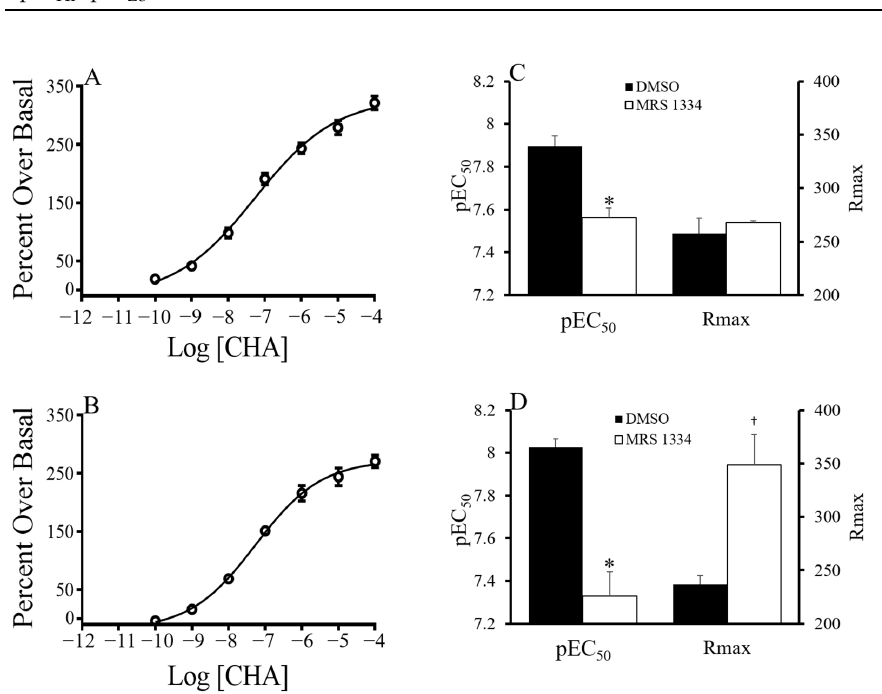
Figure 3. CHA-induced 35 S-GTP γ S binding in summer and torpid AGS brain tissue. Three brain tissues were analyzed: forebrain (n = 6, 5; summer, torpid) ( A ), hippocampus (n = 7, 7; summer, torpid) ( B ) and hypothalamus (n = 7, 6; summer, torpid) ( C ). ( D ) An increase in pEC 50 indicates an increase in the potency of CHA in the hippocampus and hypothalamus in torpid vs. summer AGS; * p < 0.05, t -test. Horizontal lines in ( E ) indicate differences between groups, p < 0.05.